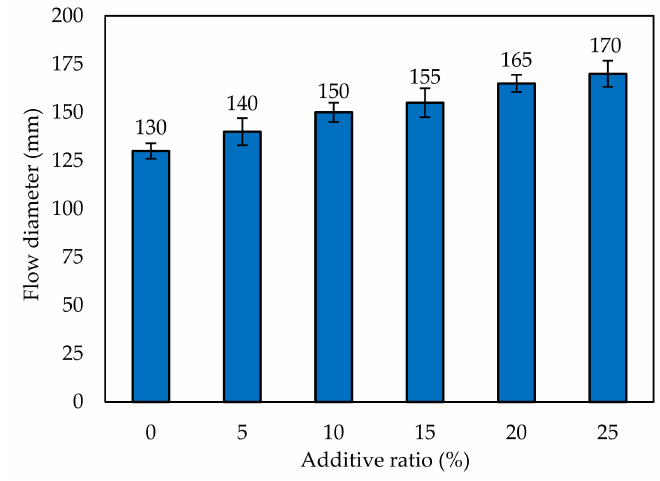
Figure 3. Flow diameters of cementitious composites.